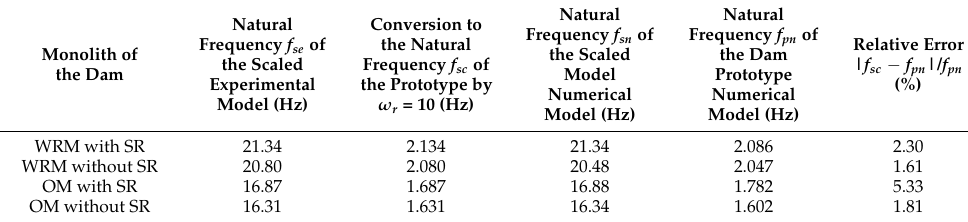
Table 4. Comparison results of natural